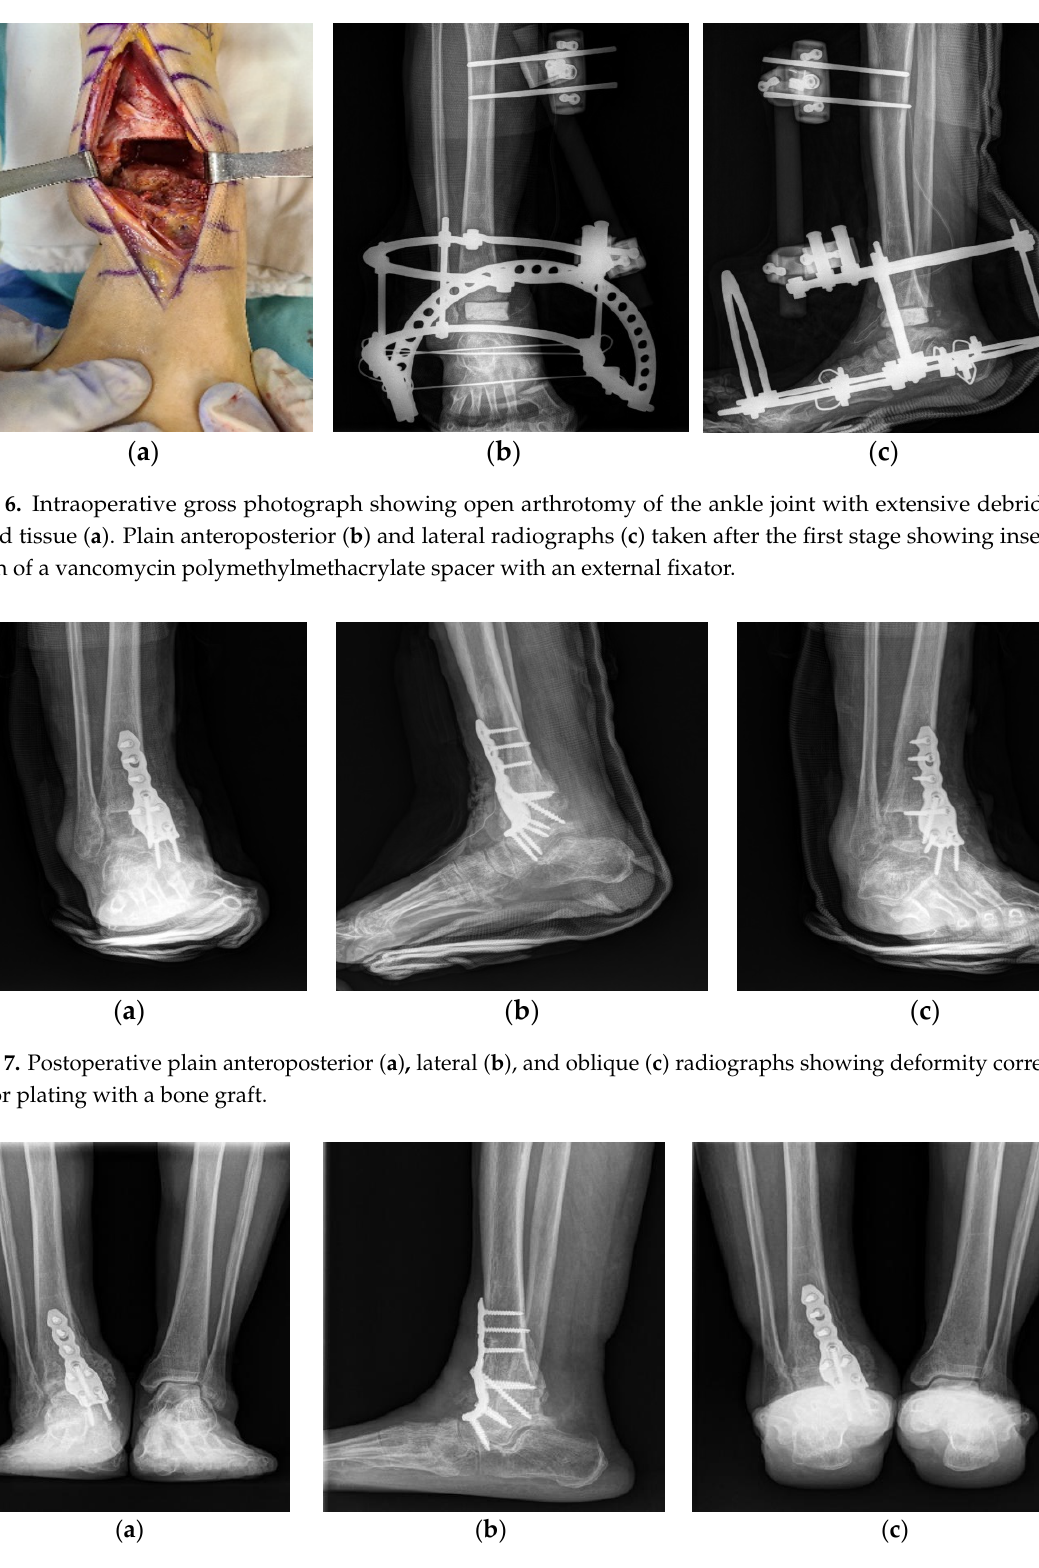
(c) Figure 8. Postoperative plain anteroposterior ( a ), lateral ( b ), and heel alignment ( c ) radiographs at the 5-month follow-up examination showing complete fusion and corrected alignment. The patient was nearly asymptomatic at the 6-month follow-up, with no discomfort in her daily life and nearly normal ability to carry out full functional activities. The leg length discrepancy was corrected to 1 cm on a follow-up scanogram (Figure 9). She had no complications or recurrent symptoms at the 1-year follow-up. The American Orthope- dic Foot and Ankle Society ankle-hindfoot score improved from 15 points preoperatively to 87 points postoperatively; the visual analog scale score for pain improved from 8 to 1.